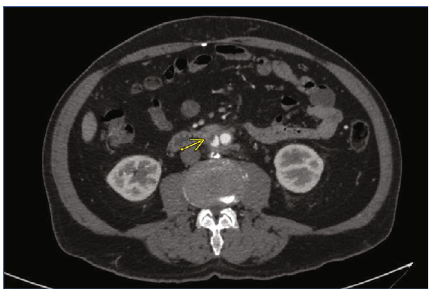
Figure 1: In fl ammation around aortobifemoral graft with loss of fat pad between graft and duodenum.